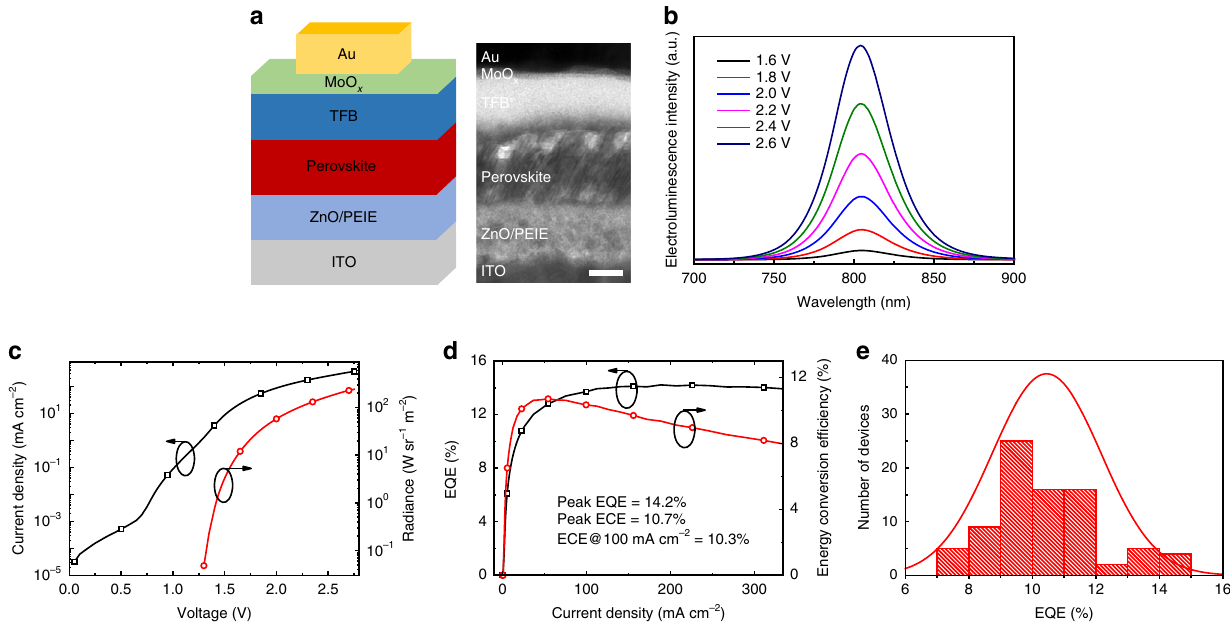
Fig. 1 PeLED device structure and optoelectronic characteristics. a Device structure and cross-sectional HRTEM image (scale bar, 20 nm). b Device EL spectra upon various biases. c Current density and radiance versus driving voltage for the highest EQE device (10 wt.%). Radiance of 241 W sr − 1 m − 2 is obtained under 2.75 V. d EQE and ECE versus current density for the highest EQE device (10 wt.%). A peak EQE of 14.2% is achieved at a current density of 188 mA cm − 2 and a peak ECE of 10.7% is obtained at a current density of 54 mA cm − 2 . e Histogram of peak EQEs measured from 82 devices, which shows an average peak EQE of 10.5% with a relative standard deviation of